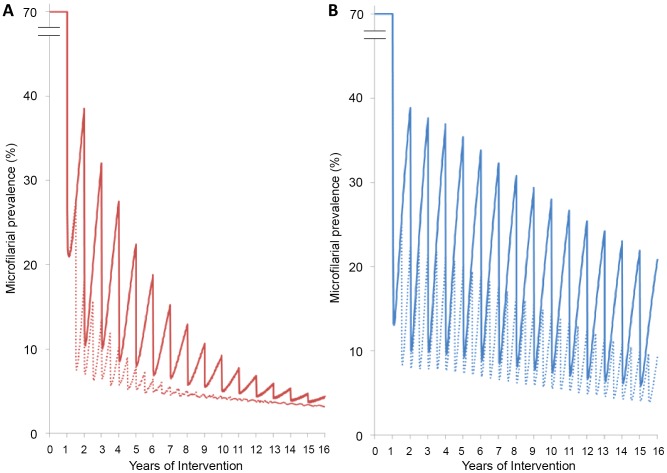
Impact on infection prevalence of annual/biannual ivermectin distribution under two assumptions of ivermectin effects.Solid and dashed lines represent, respectively, annual and biannual treatment frequency. A: Red lines correspond to model outputs assuming that ivermectin exerts a cumulative reduction in microfilarial production by the adult female worm. B: Blue lines correspond to model outputs assuming the absence of such cumulative reduction. Calibration of the model is as in Figure 2.